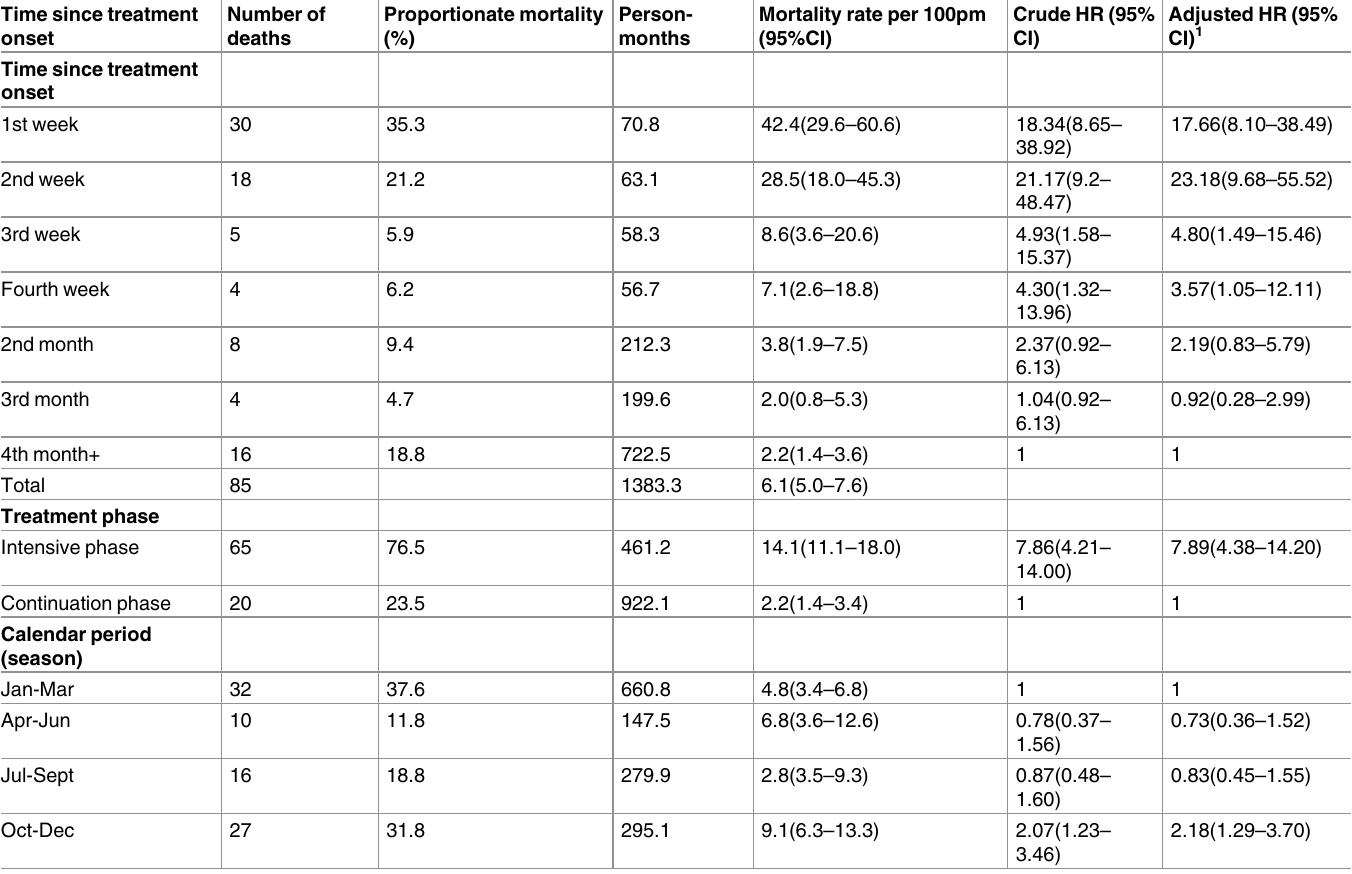
Table 4. Timing of deaths among children on TB treatment, TB clinic, Aminu Kano Teaching Hospital, Kano,